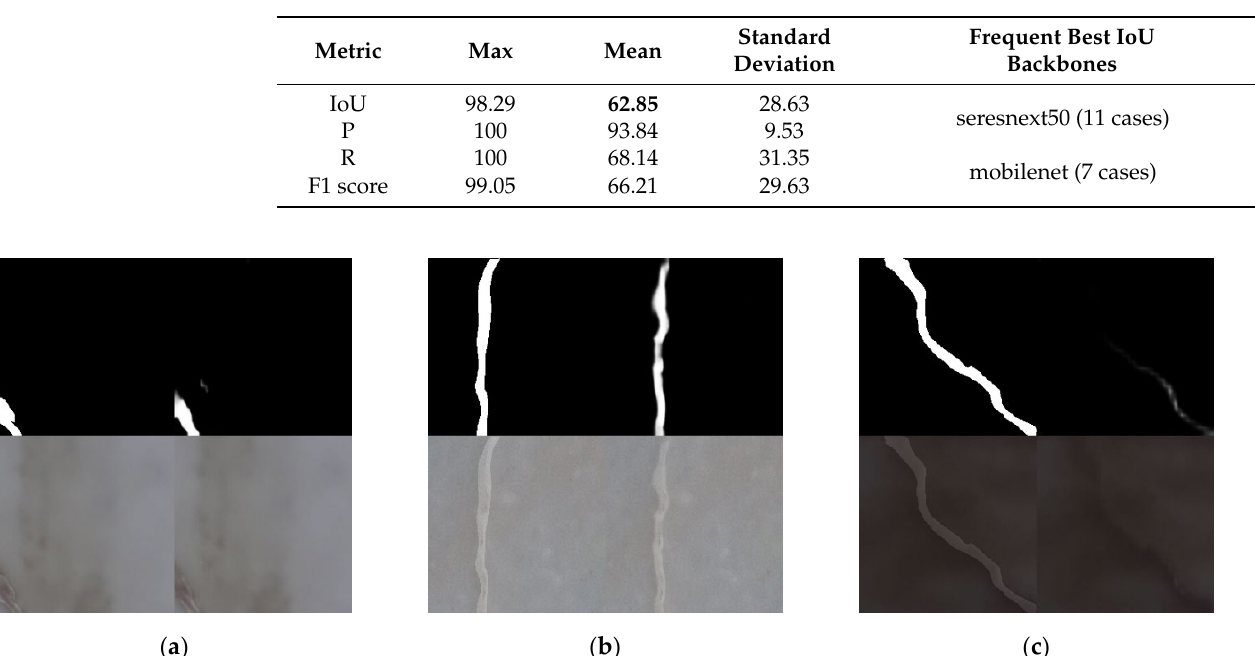
Figure 9. Indicative images of the testing set to illustrate PSPNet performance. For each image: up–